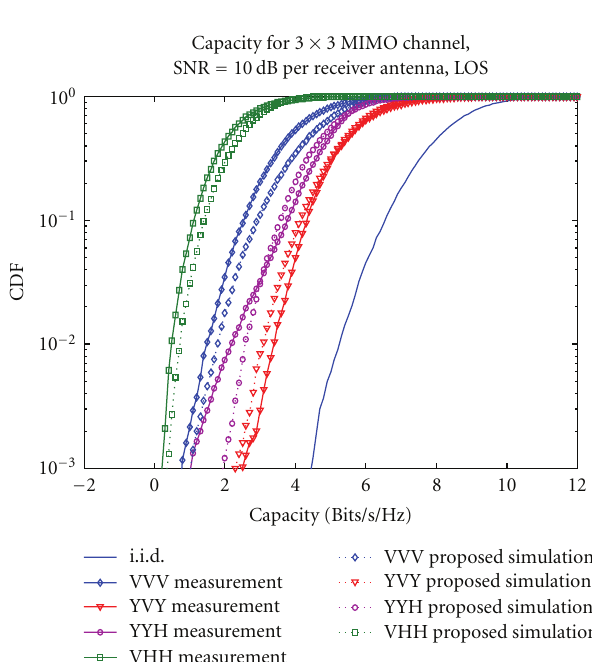
Figure 8: The plots of CDF versus capacities obtained by mea- surement analysis (solid line), proposed simulation analysis (dotted line) for dissimilar polarization systems in indoor LOS environ-